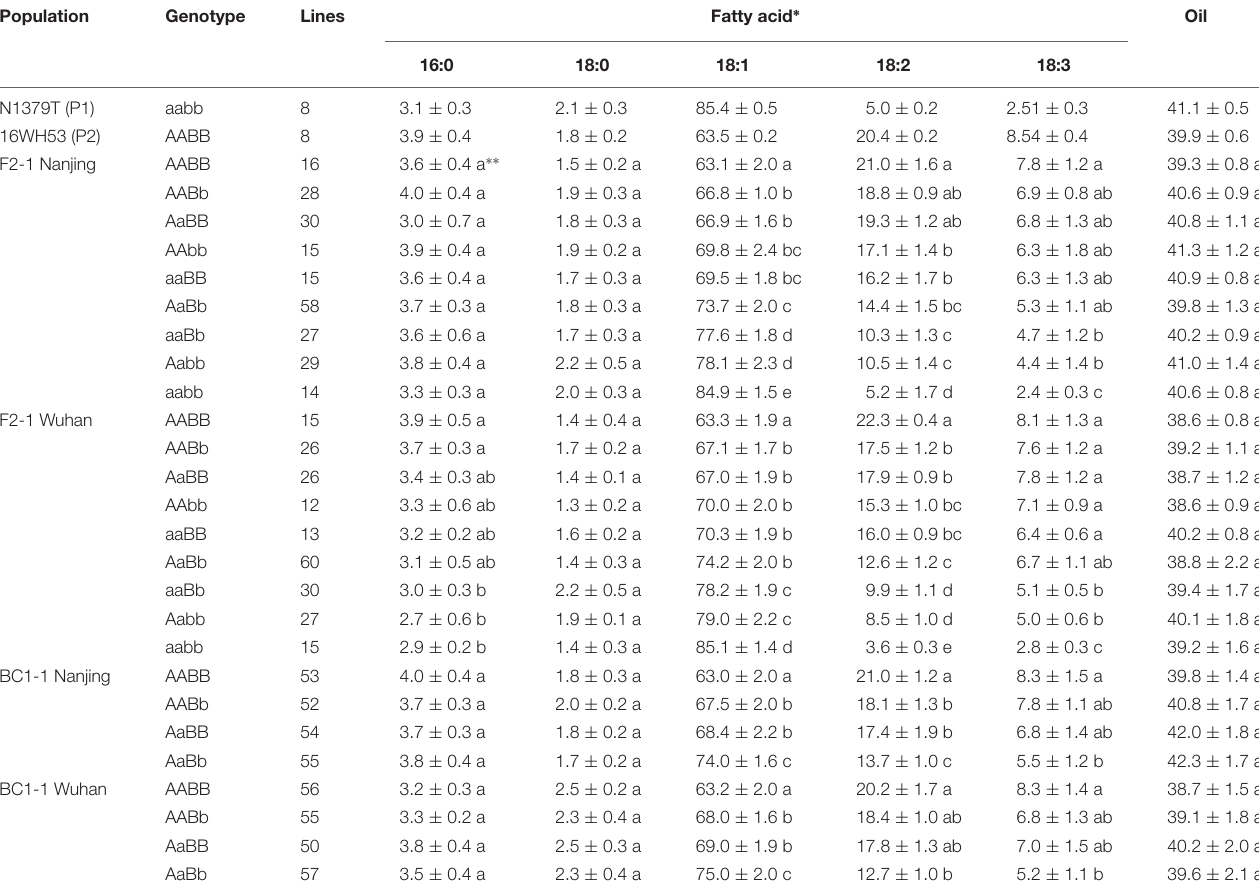
TABLE 2 | Average fatty acid percent and oil content of each genotype in the parental lines and the segregated populations at two locations. Population Genotype Lines